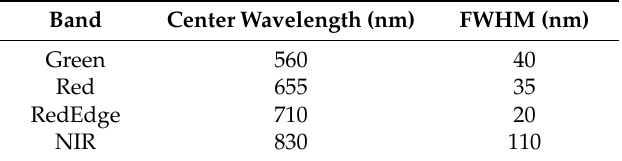
Table 2. Center wavelength and full width at half maximum (FWHM) of the SlantRange 3P camera.